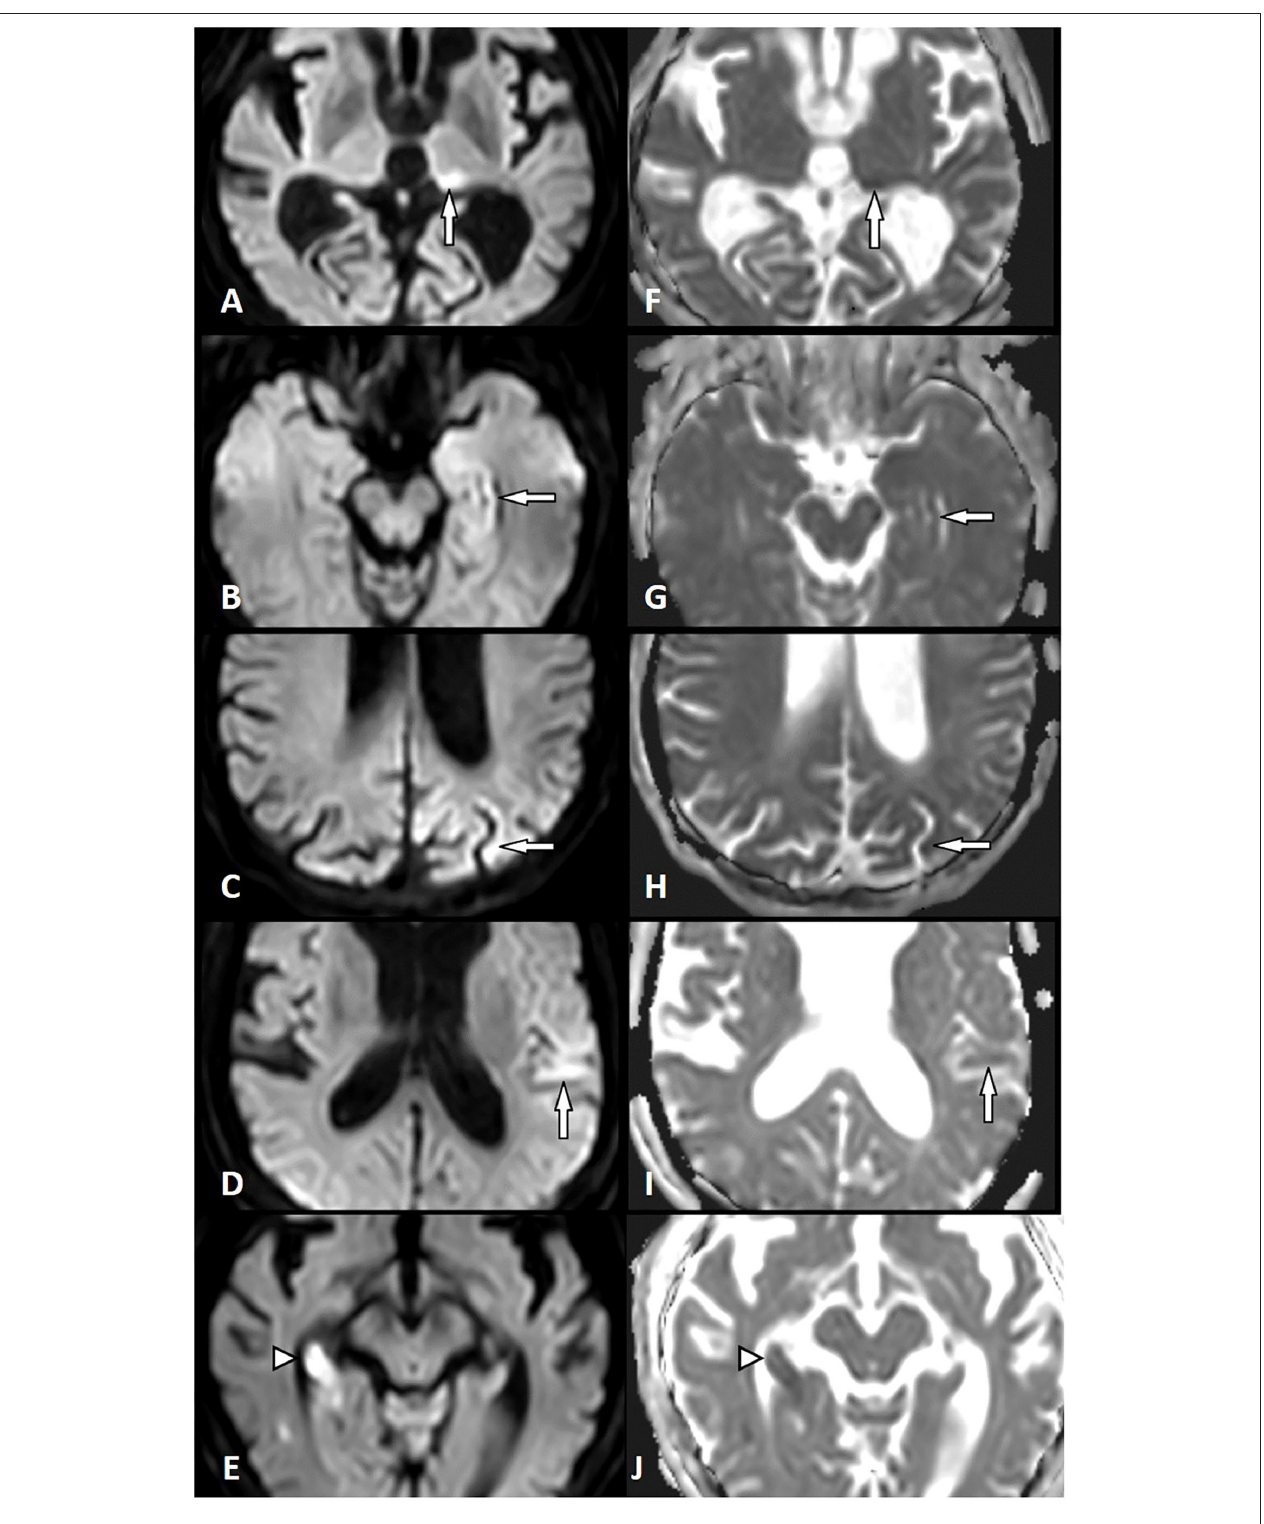
FIGURE 1 | Diffusion restriction in status epilepticus (SE) and acute ischemic stroke (AIS). Left column: Diffusion-weighted imaging (DWI). Right column: Apparent diffusion coefficient (ADC). SE-related diffusion restriction in the left pulvinar (A,F) , in the left hippocampus (B,G) , the left parietal cortex (C,H) , and the left temporal cortex (D,I) . AIS-related diffusion restriction in the right hippocampus (right posterior cerebral artery territory) (E,J) (white arrow, SE lesion; white arrowhead, AIS lesion).